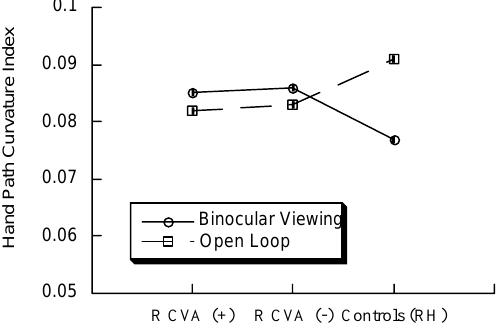
Fig. 3. Mean hand-path -curvature-index (HPC-index) for control subjects and RCVA patients (with and without neglect) under binocular and open loop viewing conditions. See text for HPC-index calculation. Error bars indicate SE’s. time of 1205msec (SD = 226), although both groups were significantly slower than the control group (mean 672 msec, SD = 168),